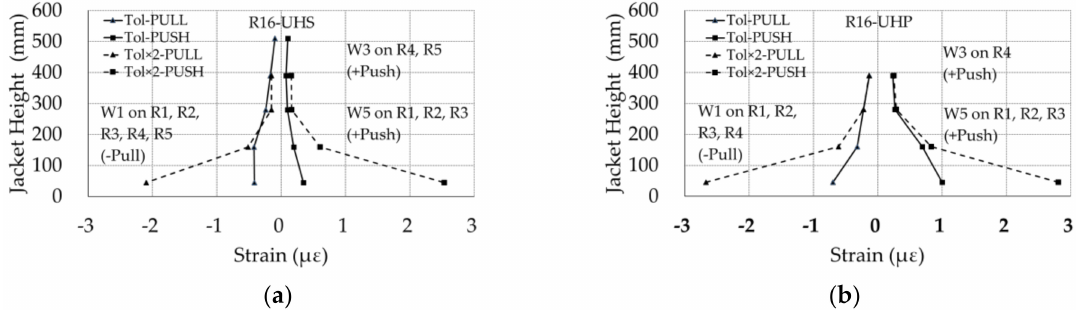
Figure 16. Experimental circumferential strain on the concrete jacket of the RR columns with: ( a ) steel fibers (R16-UHS) or ( b ) polymer fibers